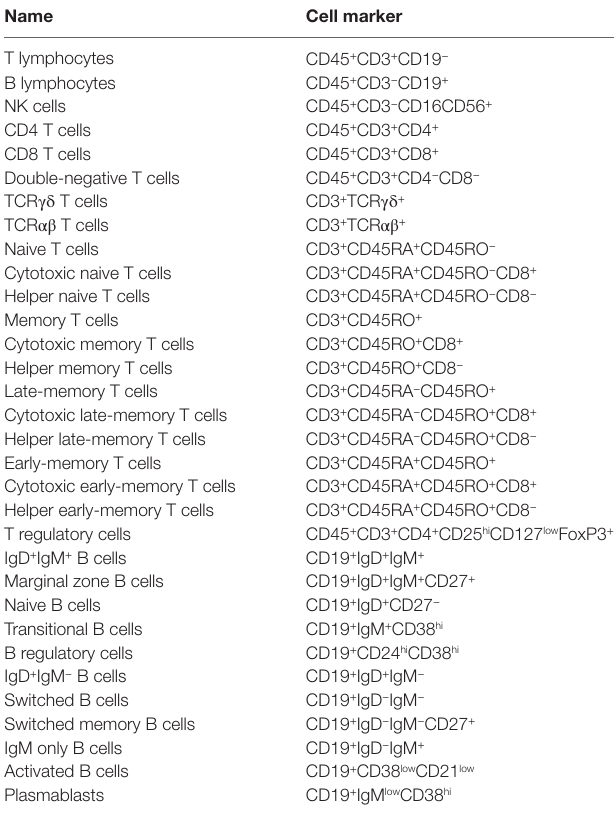
TaBle 1 | Lymphocyte subpopulation cell markers.